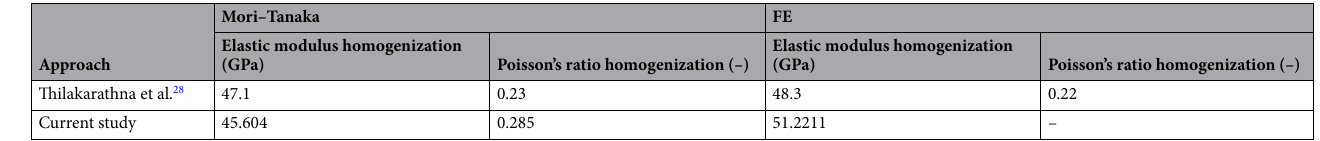
Table 14. Validation of the elastic property results in the current study and Thilakarathna et al. 28 .